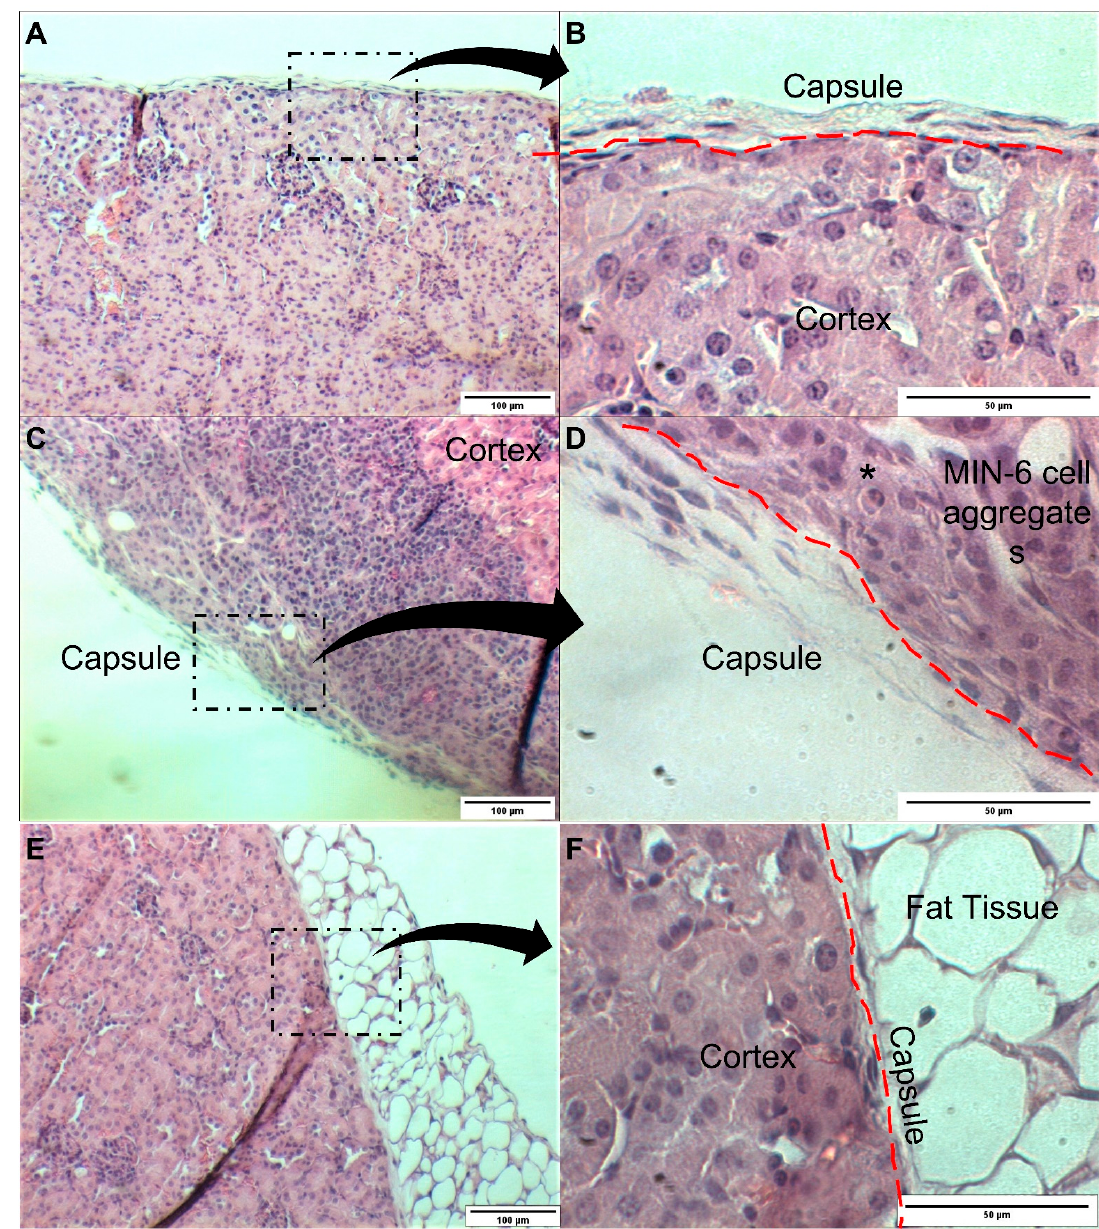
Figure 5. Histology analysis of the kidneys after 14 days post-transplantation of MIN-6 single cells. Saline group ( A , B ), cells only group ( C , D ), and encapsulated cells ( E , F ). Immune cell infiltration is shown (*). Lower magnification 10×, scale bar 100 µm. Higher magnification 40×, scale bar 50 µm.